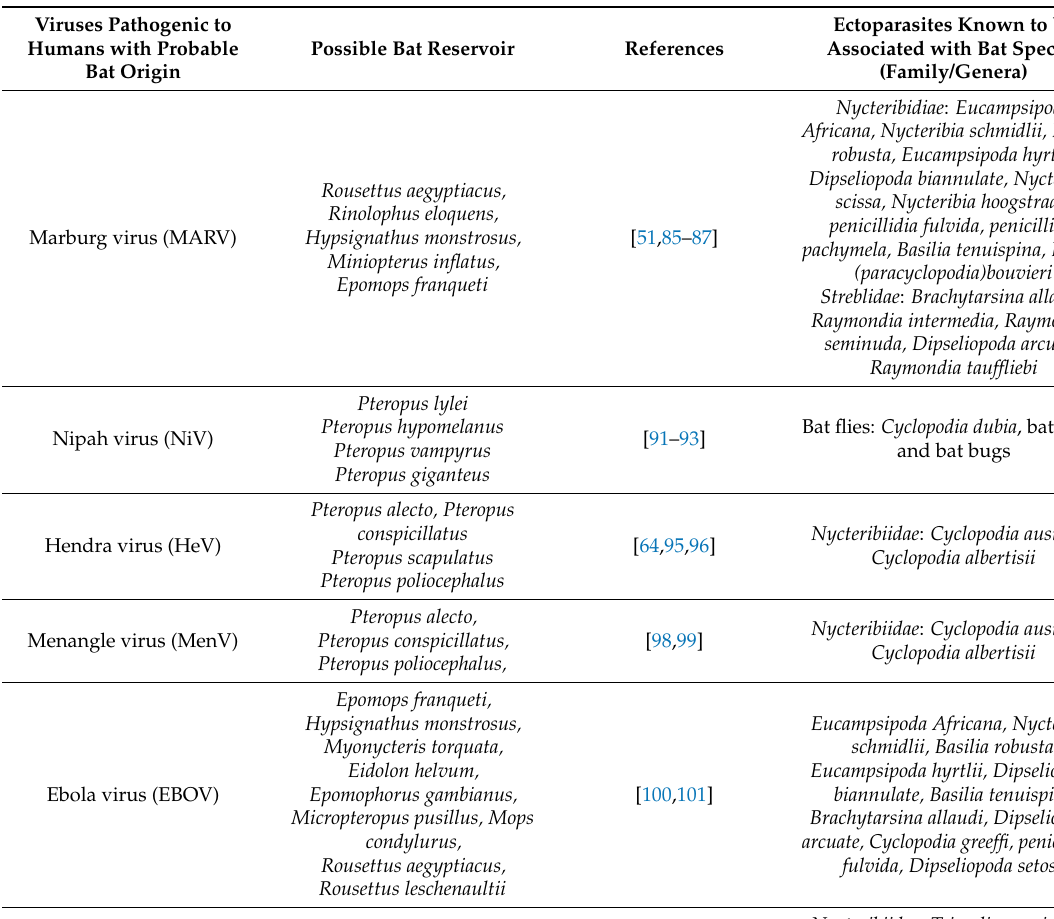
Table 3. Summary of published studies on viruses found in bat